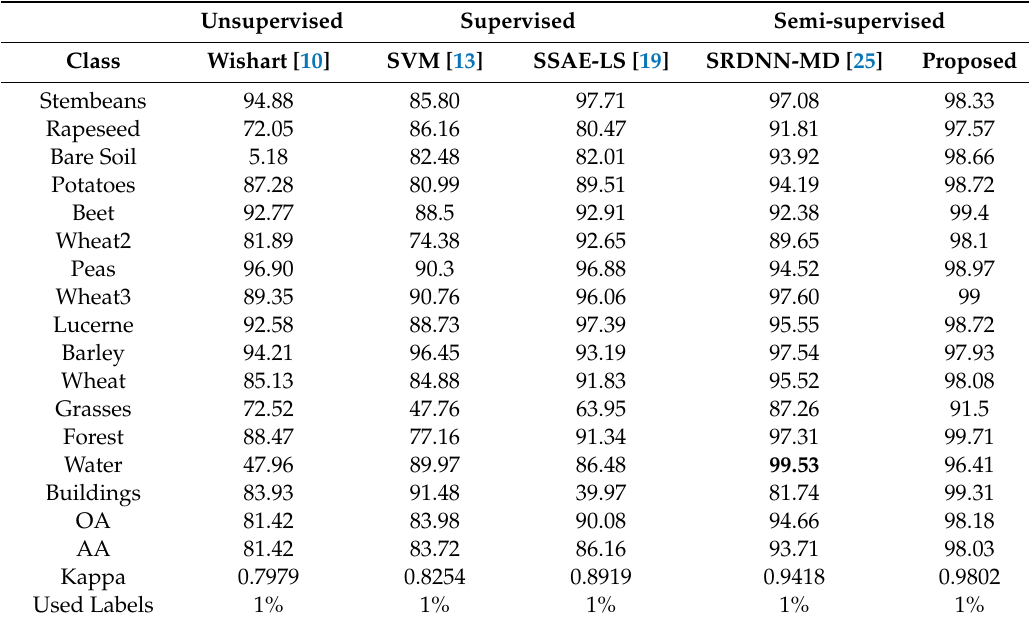
Table 2. Classification accuracy (%) comparisons on Flevoland data.